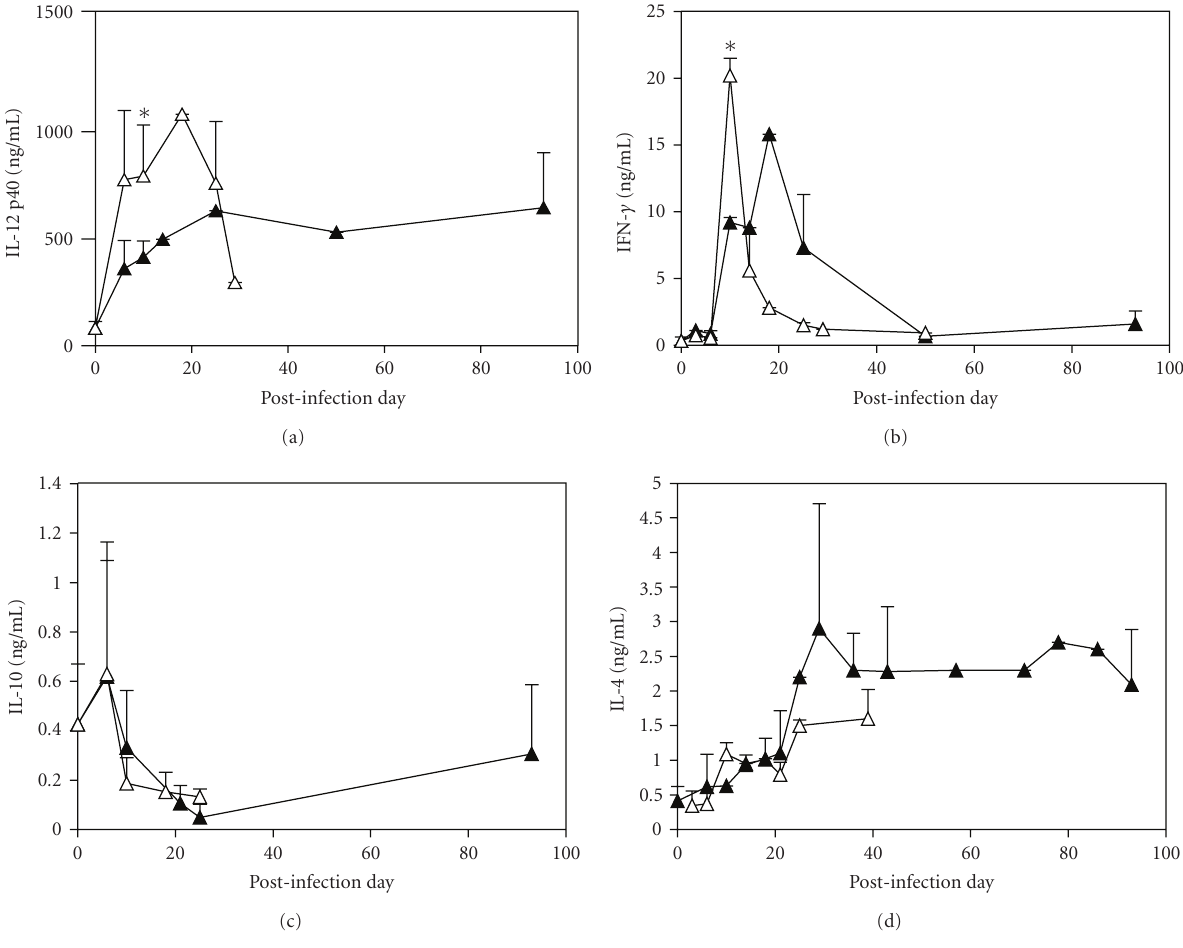
Figure 5: Serum cytokine concentration in mice infected with T. cruzi I strains. Groups of nine mice were inoculated with 1 × 10 4 BT Qro ) or Ninoa BT ( ). Serum was obtained from ocular plexus each 3rd day and pooled. Cytokines were measured by ELISA and presented ( (cid:2) (cid:0) as average of two experiments with standard deviation. (a) IL-12 p40, (b) IFN γ , (c) IL-10, and (d) IL-4. Statistical di ff erences between mice infected with either strain are indicated ( ∗ P < .